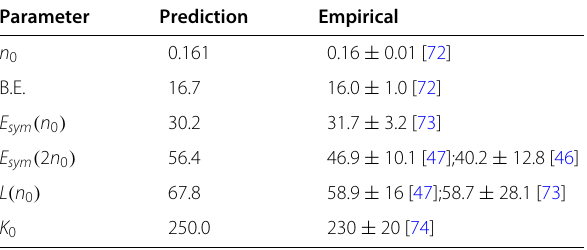
Table 1 Nuclear matter properties obtained at n 0 < n 1 /